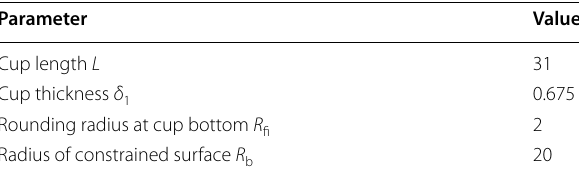
Table 5 Structural parameters of cup-shaped flexspline mm